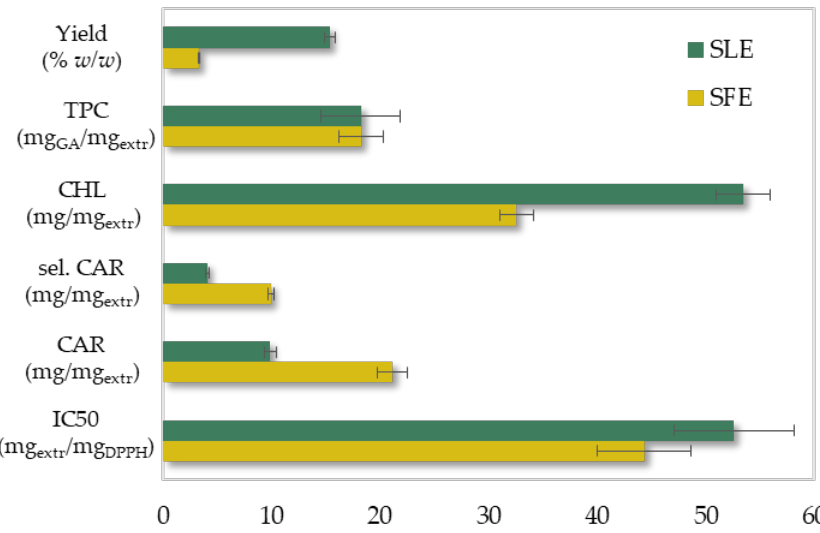
Figure 8. The examined responses of SLE and SFE extracts under the optimal extraction conditions.